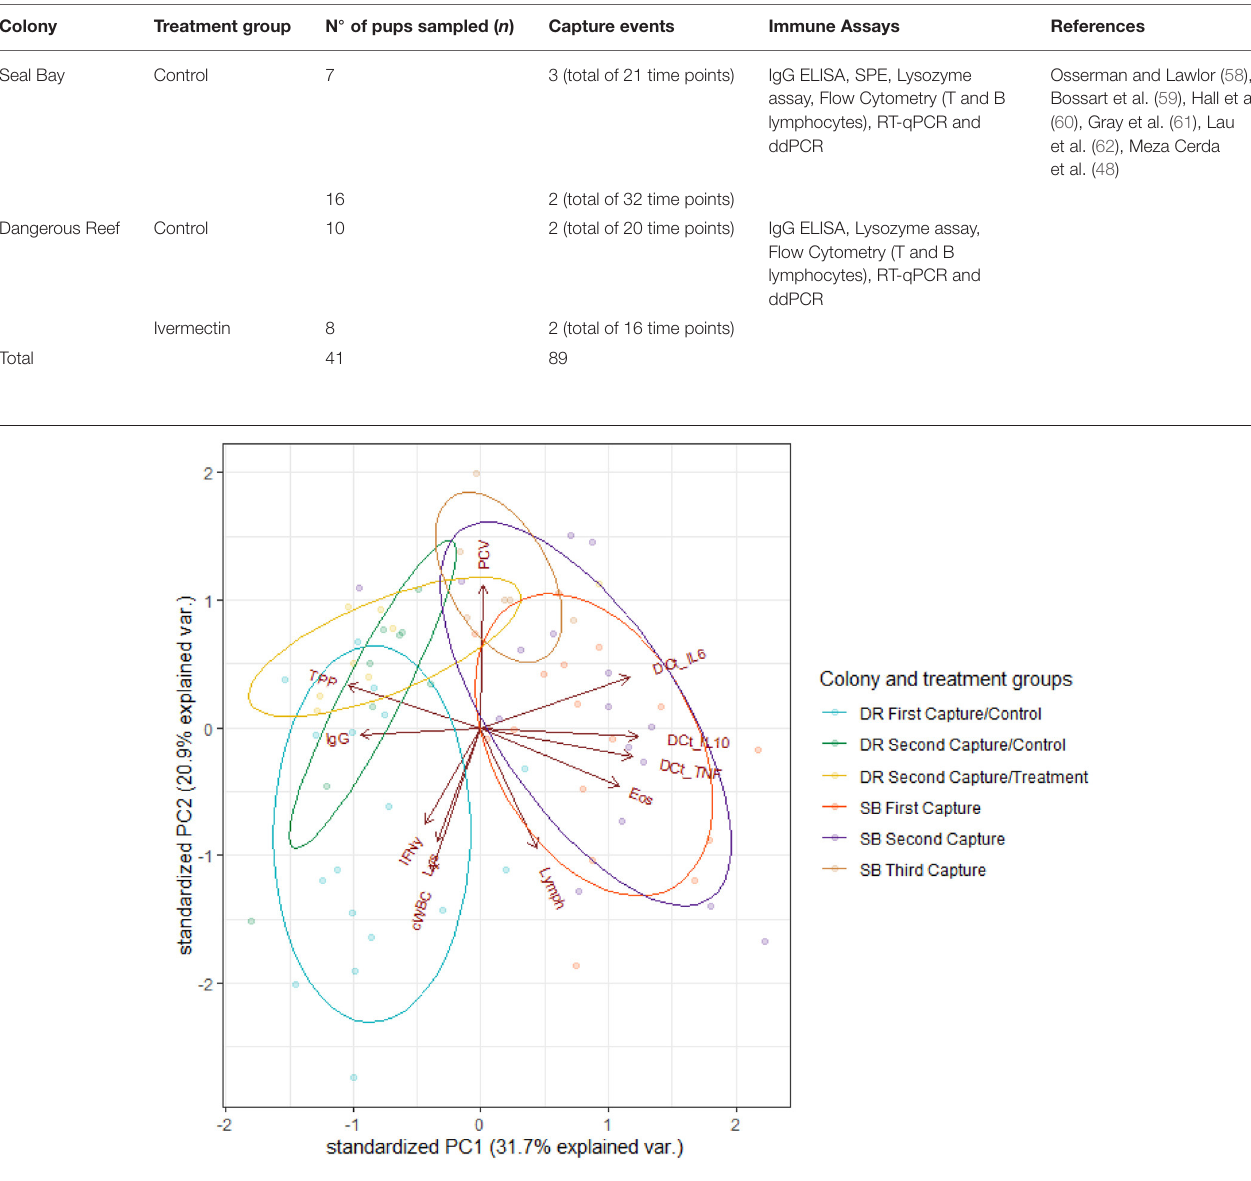
FIGURE 1 | Biplot of immunological and health parameters in Australian sea lion pups ( N. cinerea ) from Dangerous Reef (DR) First Capture-Control (blue ellipse), Dangerous Reef Second Capture-Control (green ellipse), Dangerous Reef Second Capture-Treatment (yellow ellipse), Seal Bay (SB) First Capture (red ellipse), Seal Bay Second Capture (purple ellipse) and Seal Bay Third Capture (brown ellipse). Arrows display PCA loading vectors with the arrow’s length and direction, indicating strength and increasing variance. Angles between arrows are representative of the strength of the correlation between variables, with small angles showing highly correlated variables. The dots represent individual pup samples. PCV, Pack cell volume; TPP, Total plasma protein; IgG, Immunoglobulin G; Lys, Lysozyme; cWBC, White blood cells count; Lymph, Lymphocytes count; Eos, Eosinophils count; IFN γ , Interferon- γ ; 1 Ct IL-6, 1 Ct IL-10, 1 Ct TNF α .